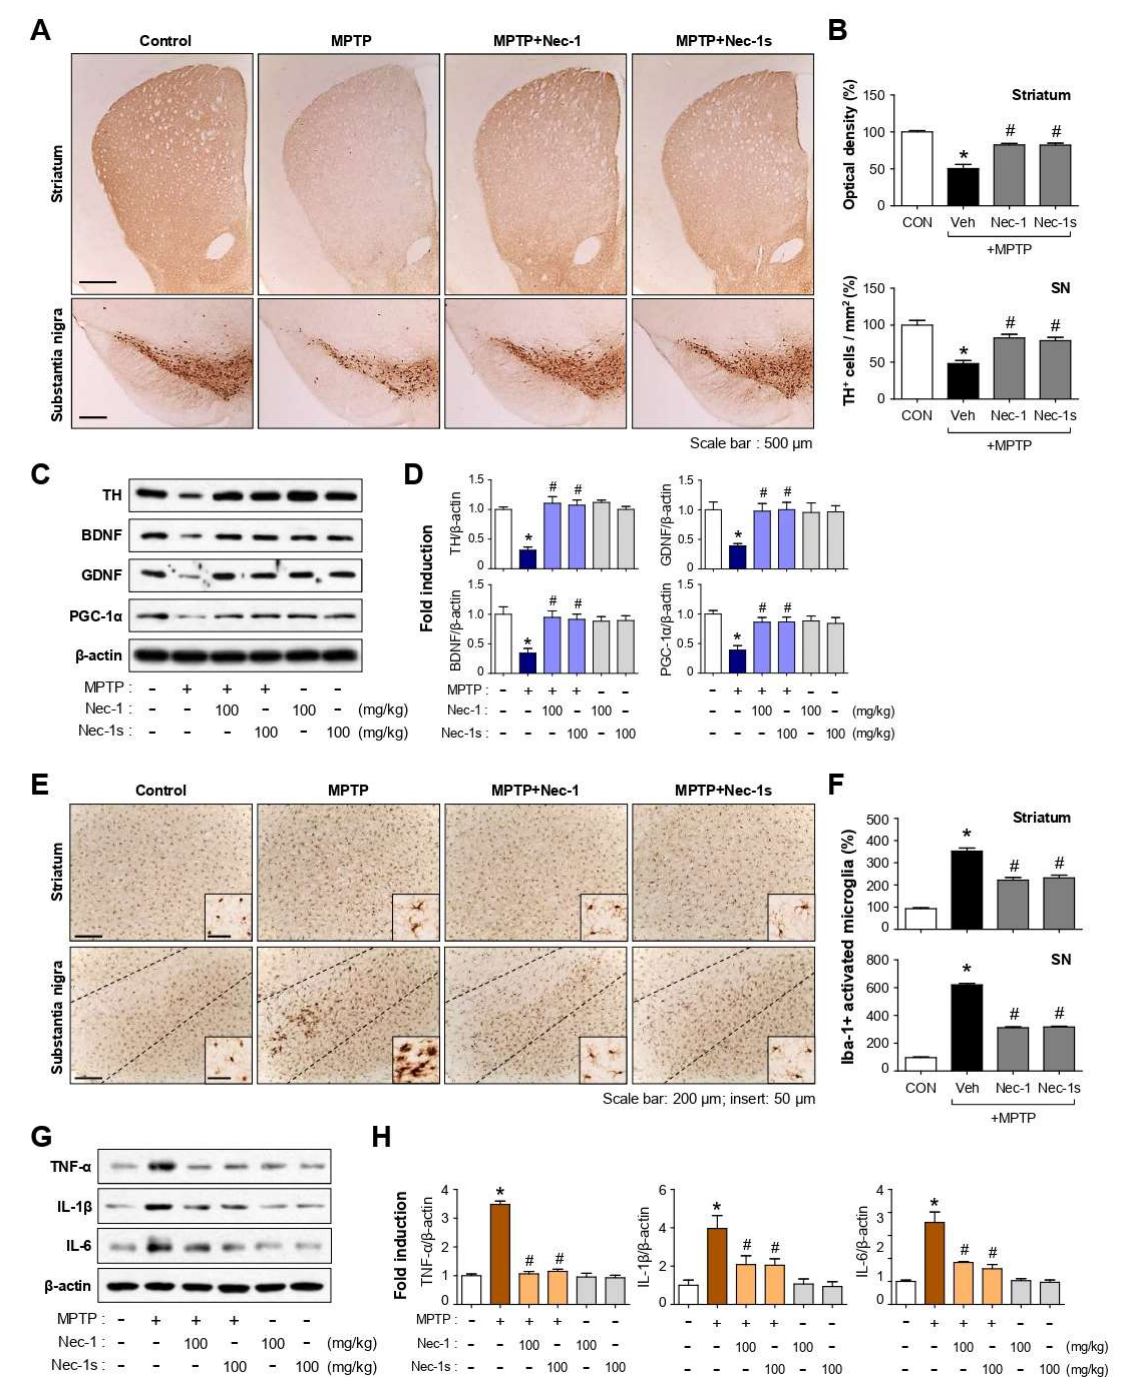
Figure 7. Effect of Nec-1 and Nec-1s on dopaminergic neuronal cell death, microglial activation in the brains of MPTP-injected mice. ( A ) Representative images of TH-positive neuronal cells in the striatum and SN (each group n = 4–5). ( B ) Quantitative analysis was performed by measuring the optical density of TH-positive fibers in the striatum and the number of TH-positive cells in the SN. ( C ) Western blot data showing the effect of Nec-1/Nec-1s on the expression of neurotrophic factors in the SN. ( D ) Quantification of Western blot data. ( E ) Immunohistochemical staining for Iba-1 (microglial marker) in striatum and SN, and ( F ) quantification of the number of Iba-1-positive-activated microglia in the striatum and SN. ( G ) Western blot data shows the effect of Nec-1/Nec-1s on the expression of proinflammatory cytokines in the SN. ( H ) Quantification of Western blot data. Data are shown as the mean ± SEM. * p < 0.05 vs. control group; # p < 0.05 vs. MPTP